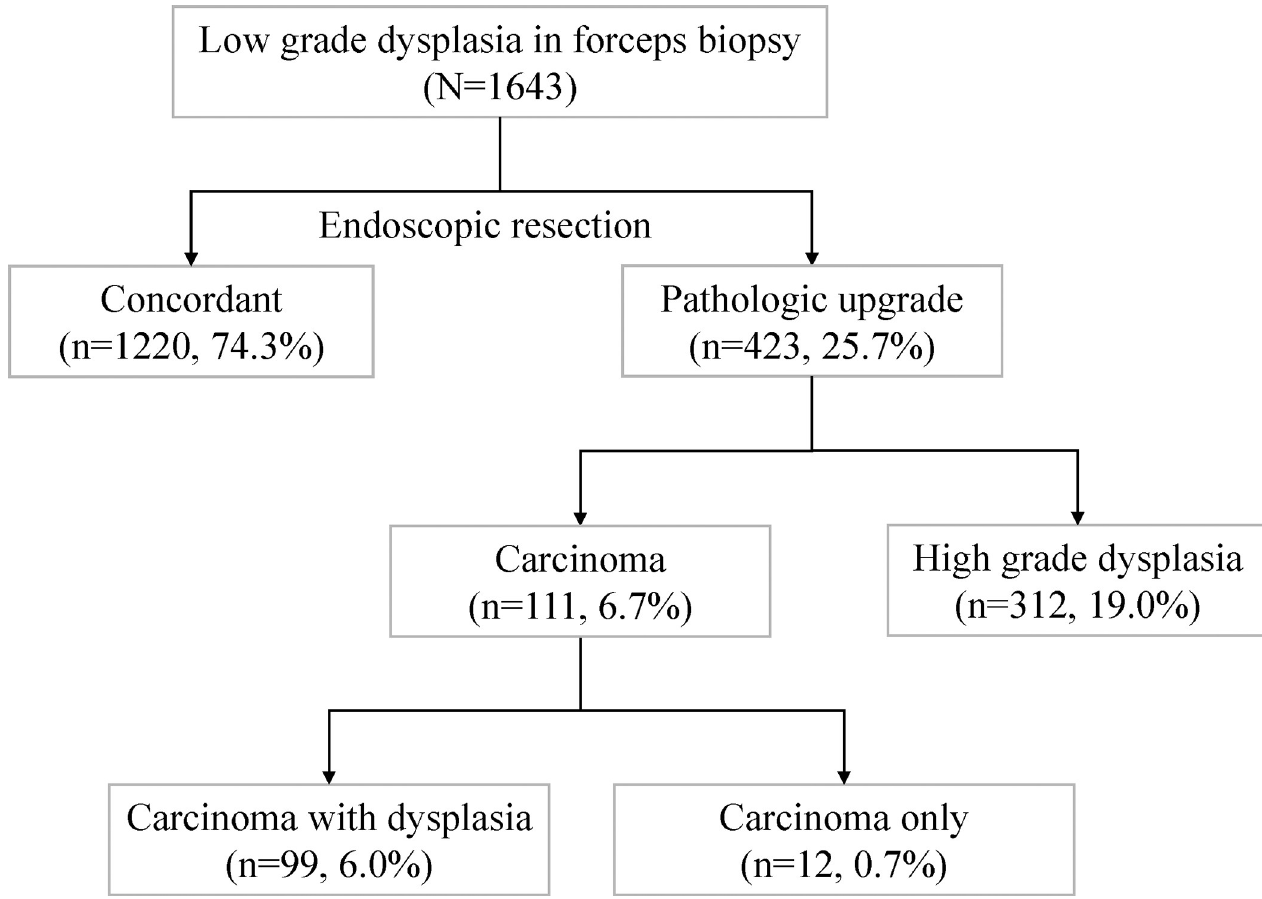
Fig 1. Pathologies of the endoscopic forceps biopsies and resected specimens.